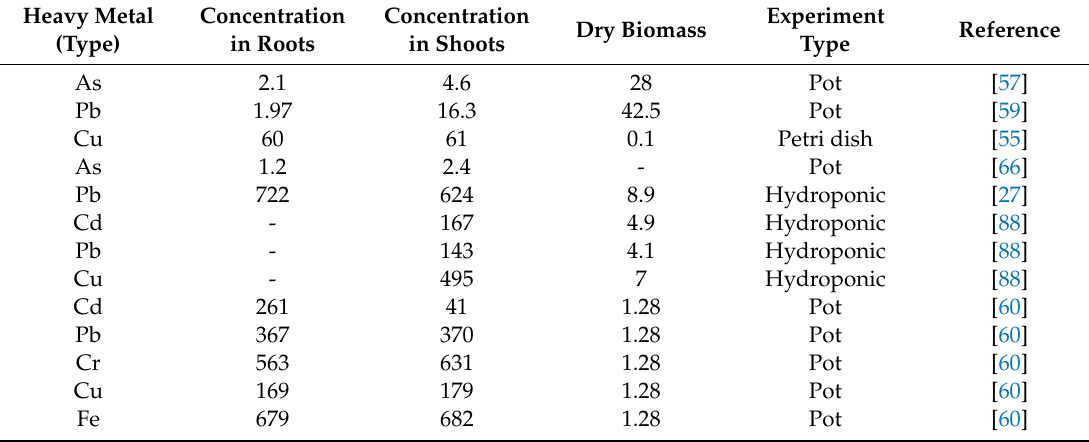
Table 1. Accumulation of di ff erent heavy metal in roots (mg / kg) and shoots (mg / kg) of jute along with the dry weight (g / plant) and metal removal from the contaminated